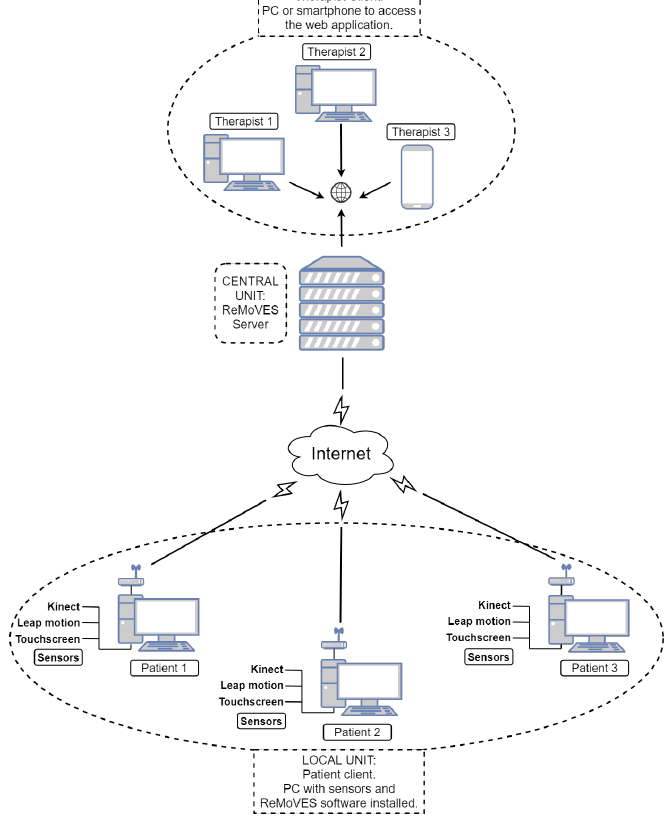
Figure 4. Hardware architecture of ReMoVES.